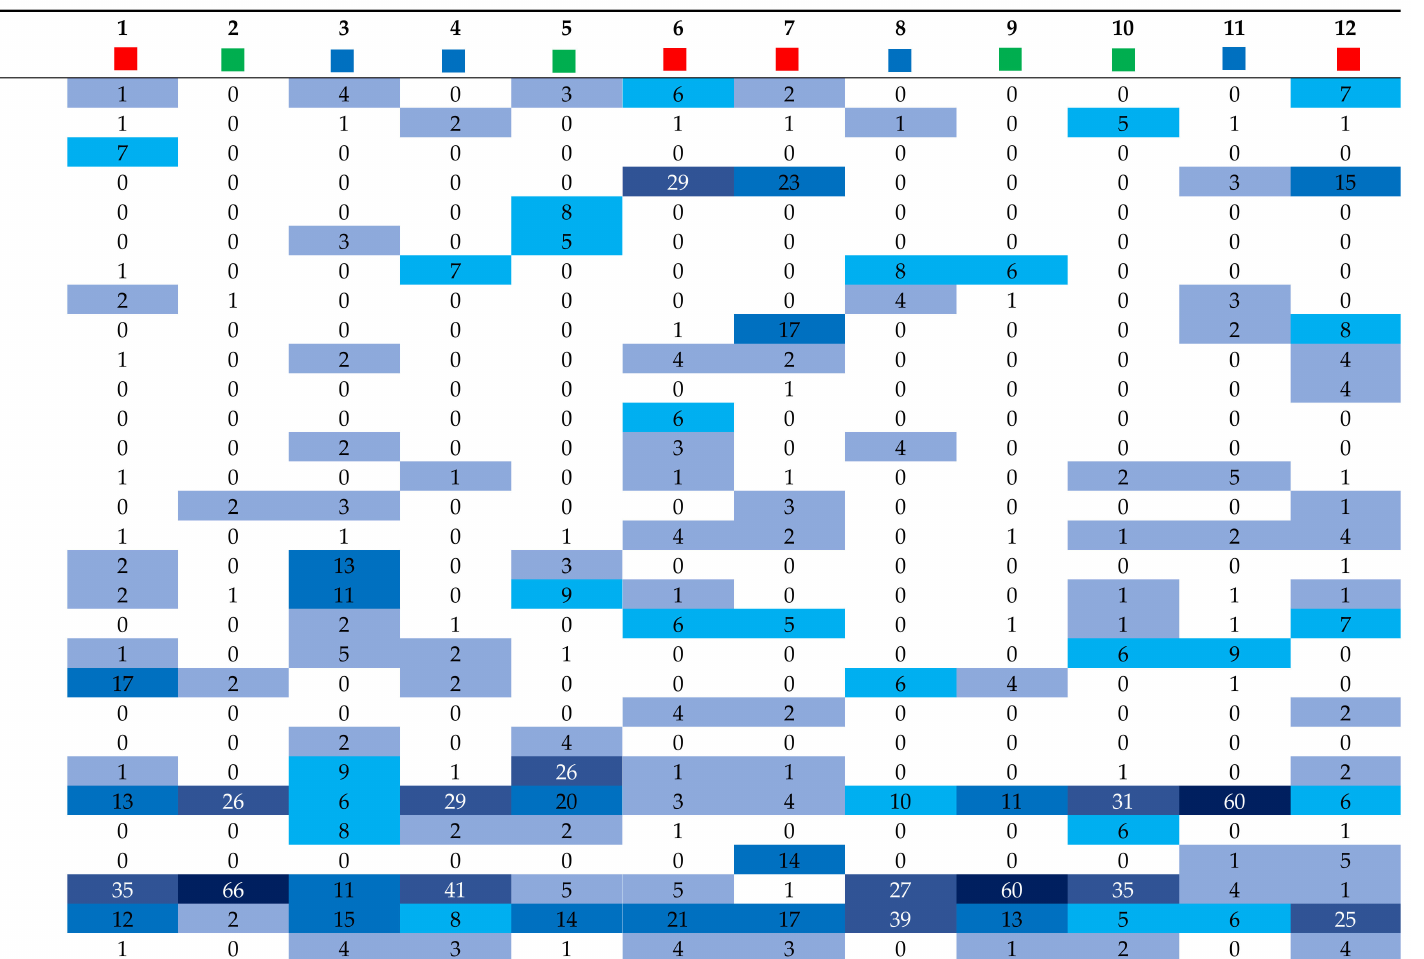
Figure 4. Heatmap showing the distribution of bacteria at the genus level and at higher taxa levels in water from drinking water fountains. The letters in brackets correspond to family (F), order (O), class (C) and phylum (P). The numbers indicate the relative abundance (%) of each taxon at each site. Fountain types are A (green), B (blue) and C